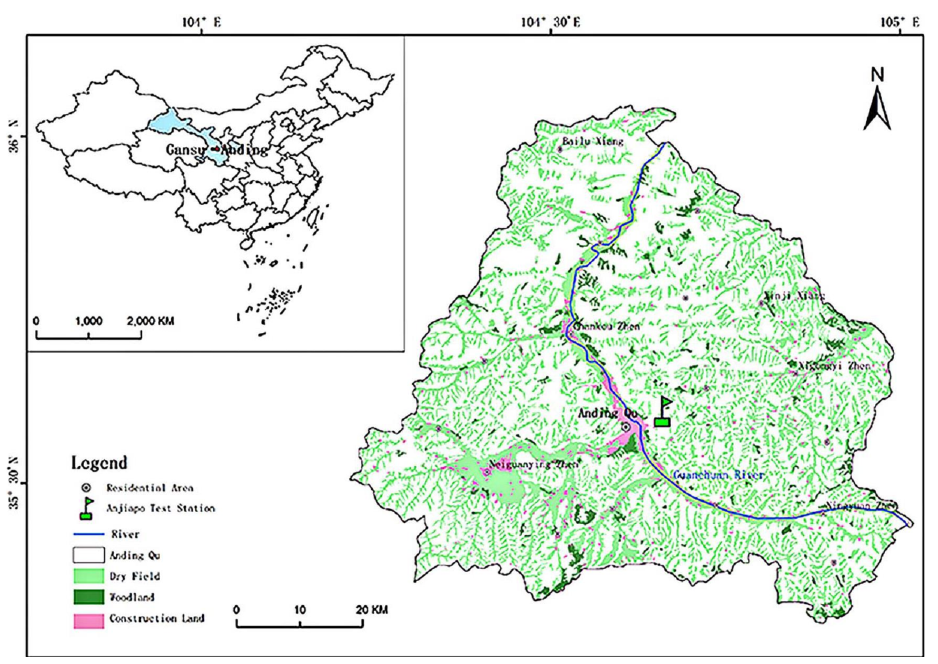
Figure 1. The geographical location map of the study